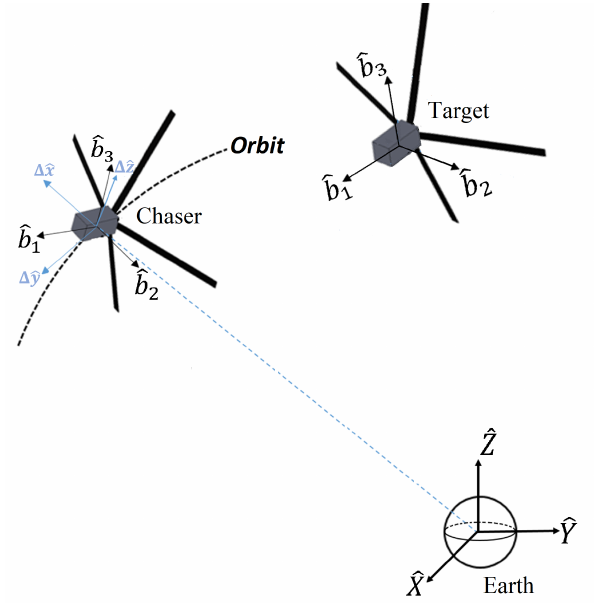
Figure 2. Coordinate